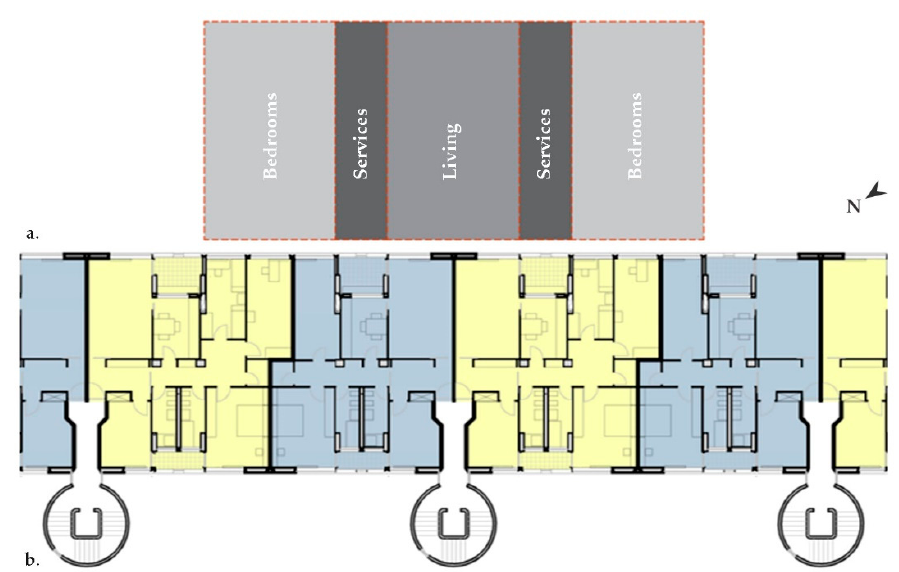
Figure 3. Case study building: Functional distribution ( a ) and section of a standard floor plan ( b ).